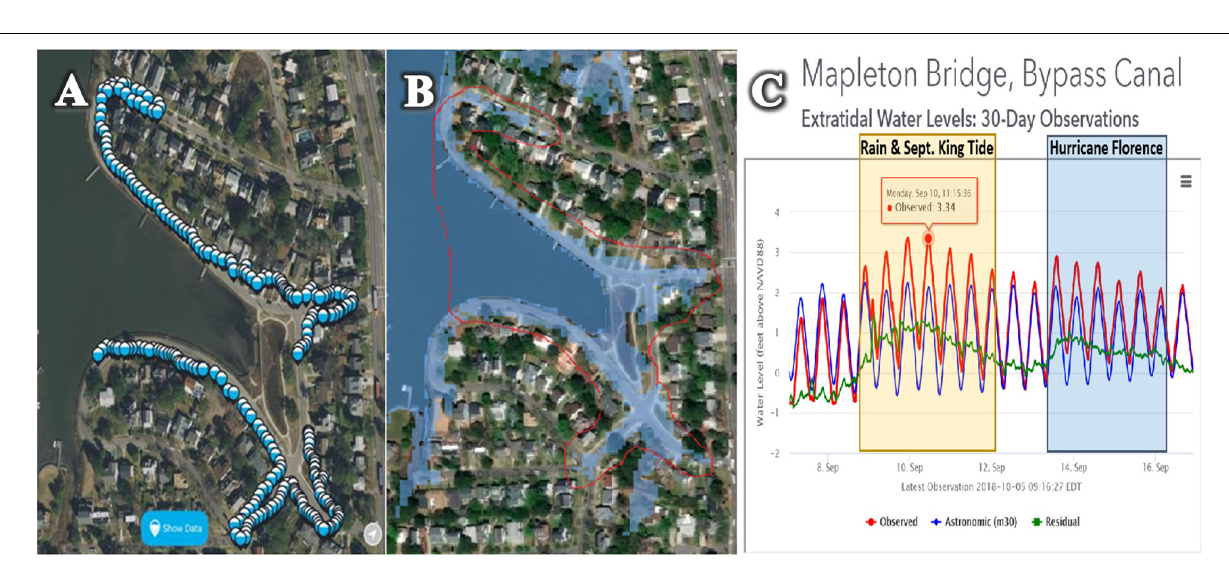
FIGURE 7 | (A) Sea Level Rise Mobile App GPS data compared with (B) Tidewatch geospatial inundation forecast at 11:15 am local time on September 10, 2018, in Larchmont, Norfolk, VA, after (C) 6 inch of rainfall concomitant with the Sept. King Tide was detected at a nearby weather station just 4 days prior to the arrival of 2018 Hurricane